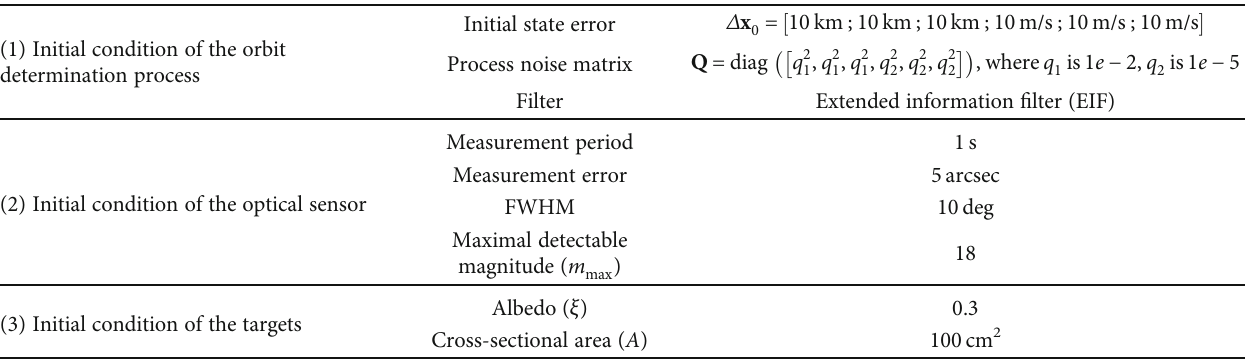
Table 1: Initial conditions of parameters in the simulation.